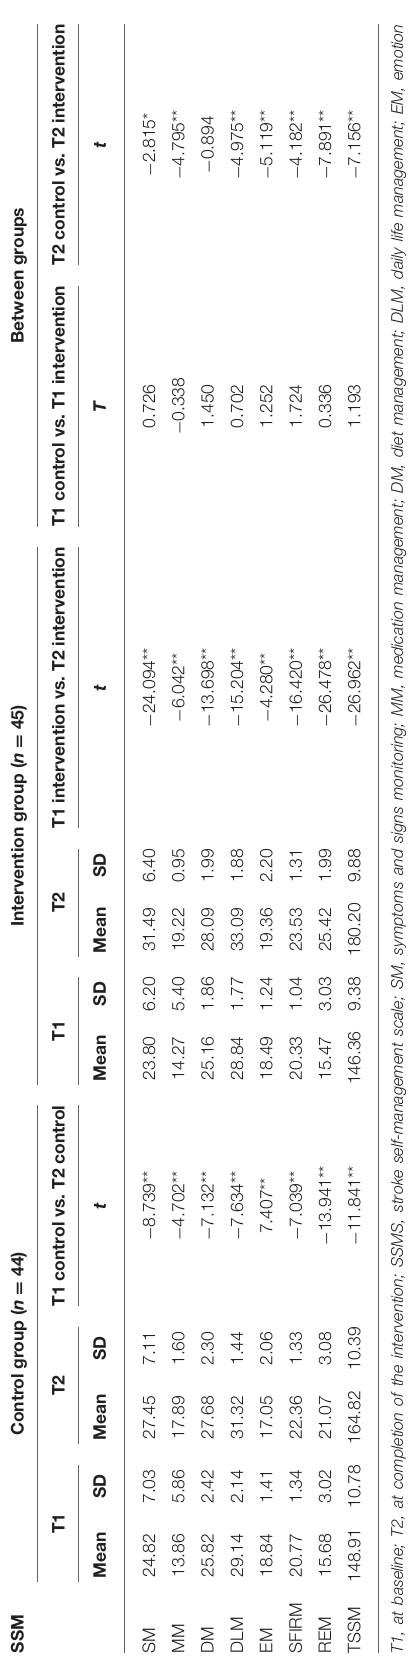
FIGURE 2 | Differences between groups in scores of SSMS at completion of the intervention. SSMA, stroke self-management scale; SM, symptoms and sign monitoring; MM, medication management; DM, diet management; DLM, daily life management; EM, emotion management; SFIRM, social function and interpersonal relationship management; REM, rehabilitation exercise management; TSSM, total stroke self-management; a P < 0.01.